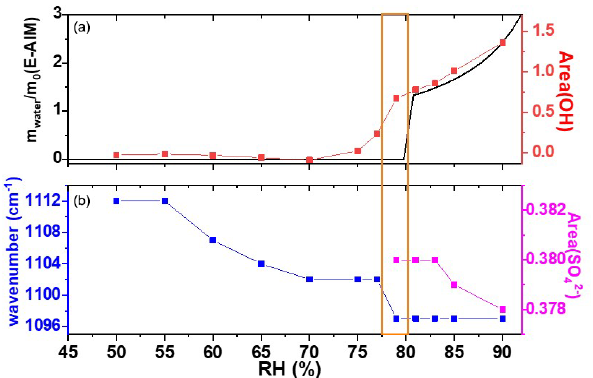
Figure 3. (a) Predicted M water /M 0 and the area of the OH stretch- ing peak as a function of RH; (b) the center wavenumber and the area of the symmetrical stretching vibration peak of SO 2 − aqueous AS nanoparticles as a function of RH. The black curve shows the E-AIM predictions. The orange box indicates the deli- quescence relative humidity